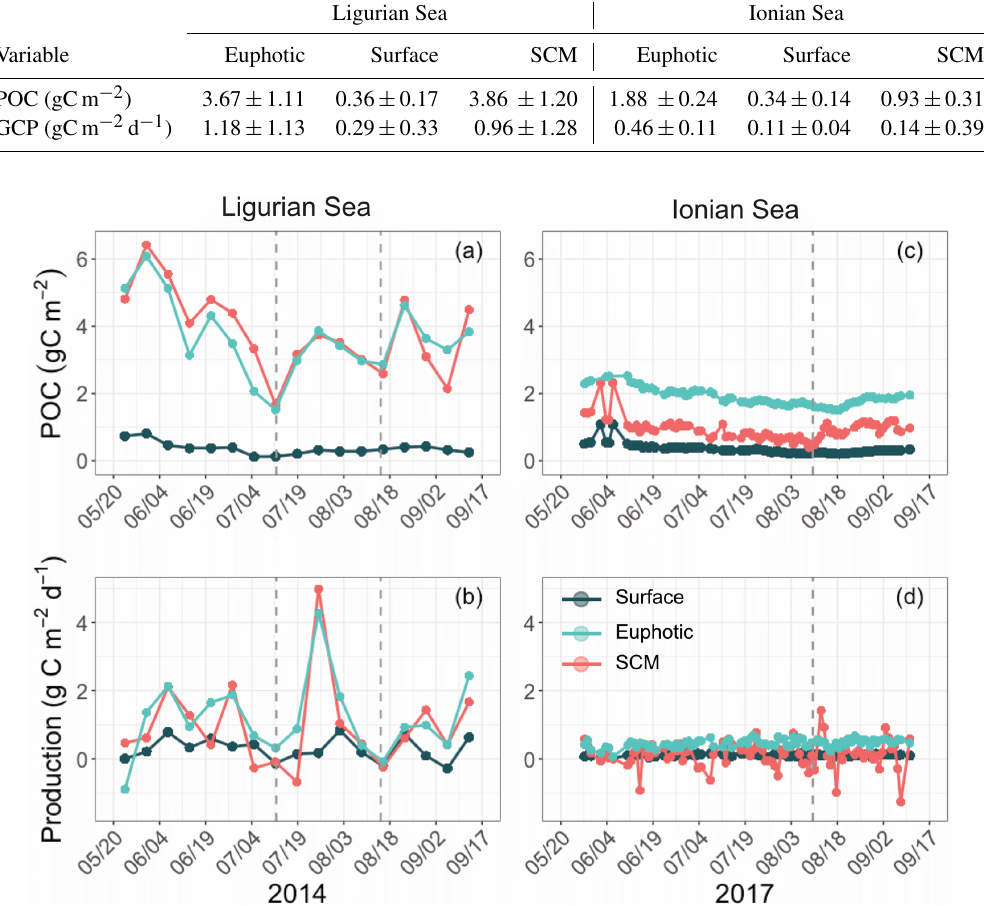
Figure 7. Temporal evolution of the POC and community production derived from the diel cycle of c p in the Ligurian Sea (a, b) and the Ionian Sea (c, d) and integrated in three different layers of the water column: surface (dark green), euphotic (light blue) and SCM (red) layers. The dotted lines indicate the dates when c p in the SCM layer reaches a minimum. Please note that the date format in this figure is